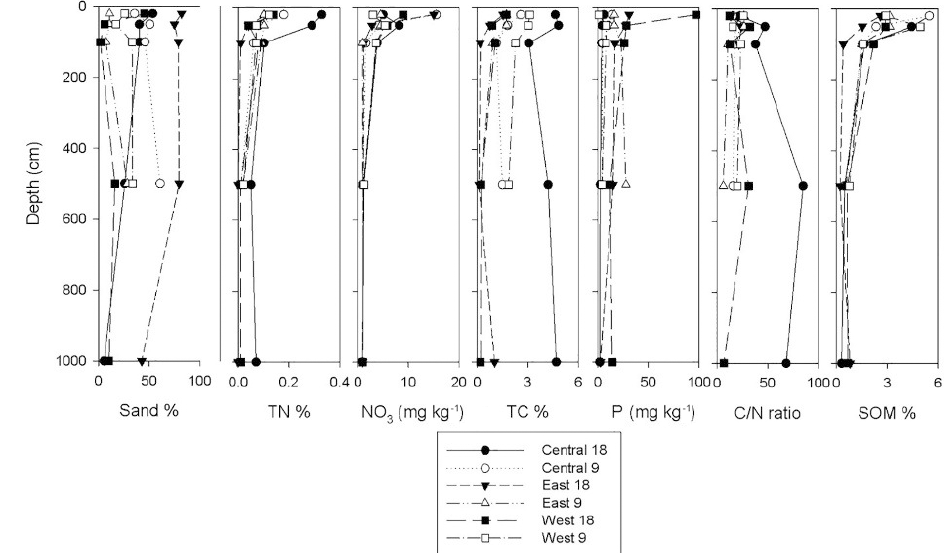
Figure 3. Profile of selected soil constituents with depth at the six Iowa golf